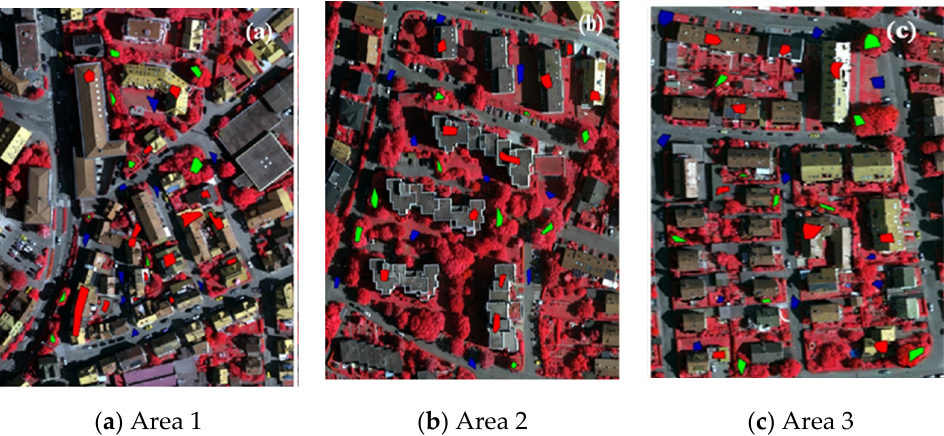
Figure 3. Some characteristic examples of our color NIR image data for the three described areas. In this figure, we have also depicted the polygons selected by the user to create the labeled dataset.